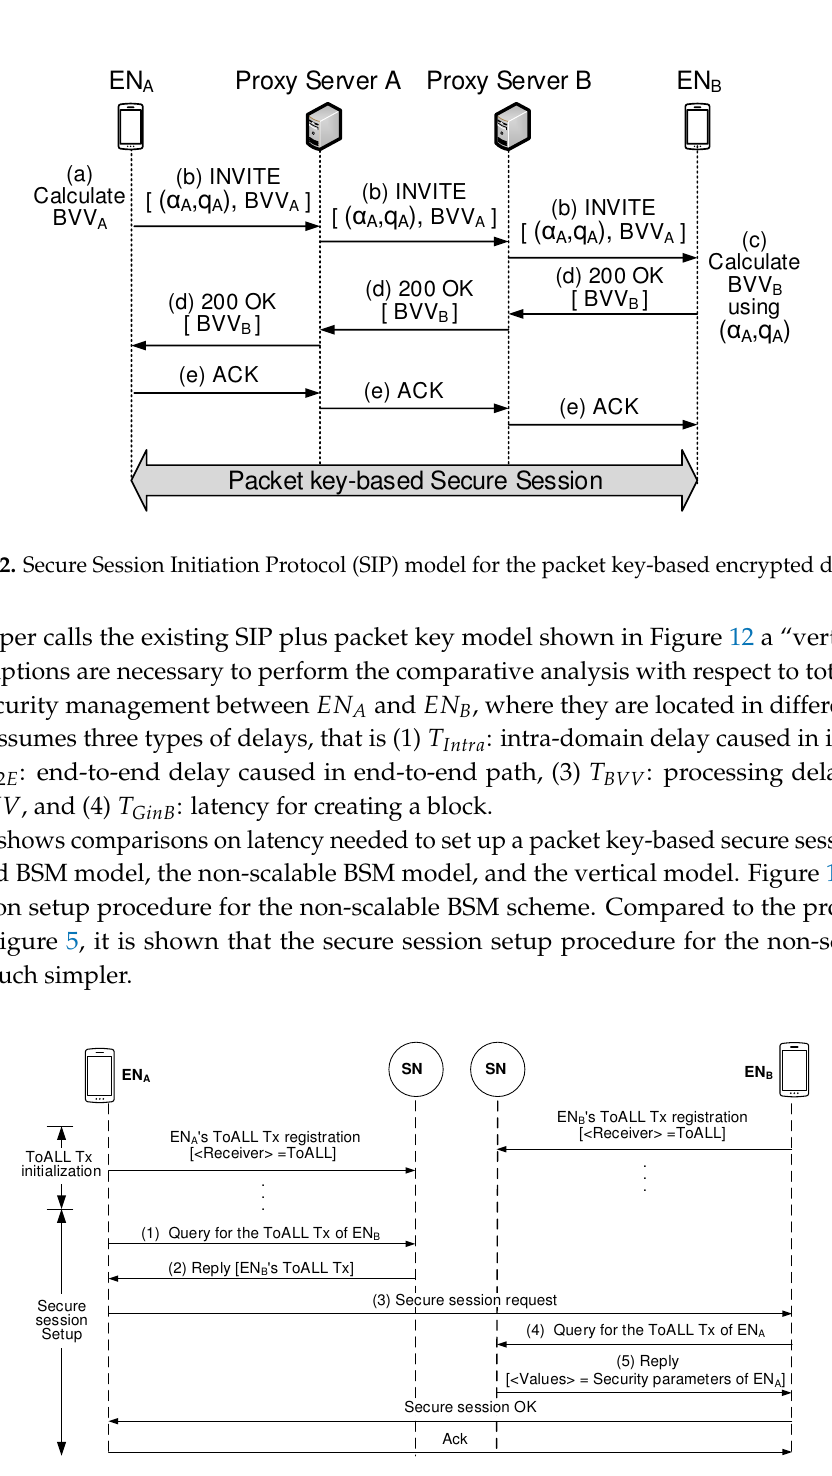
Figure 13. Secure session setup procedure in the non-scalable BSM